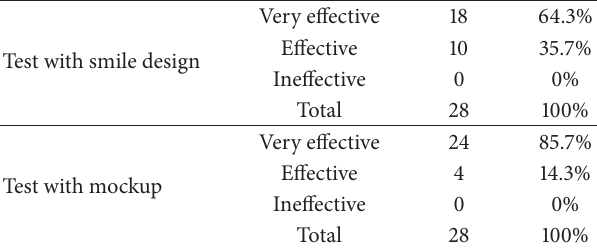
Test with smile